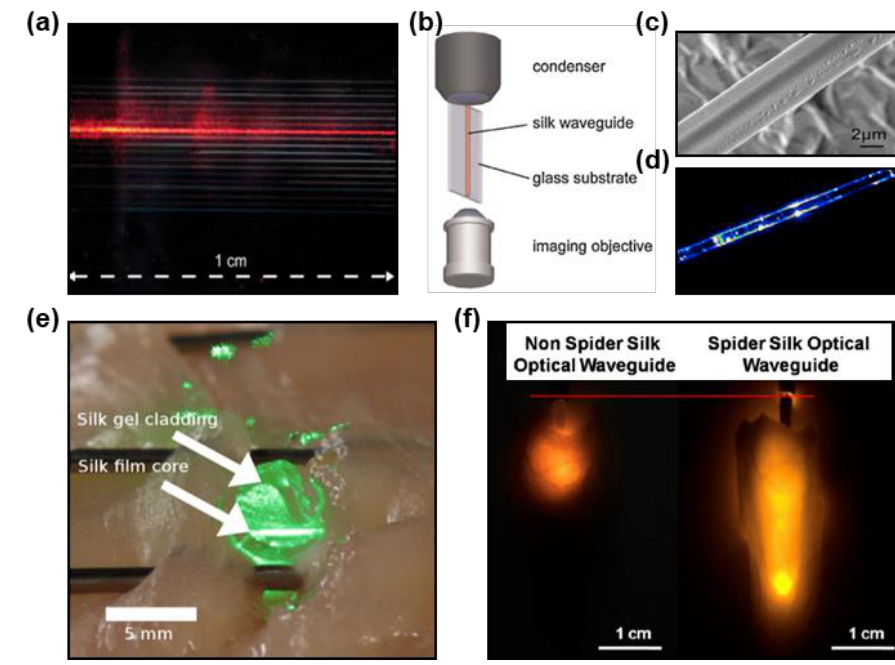
Figure 3. Waveguides made of natural materials. ( a ) Silk optical waveguide. Reproduced with